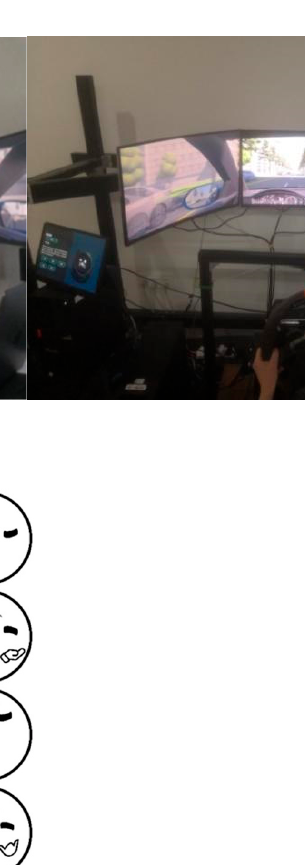
Figure 4. Robot for experiment.